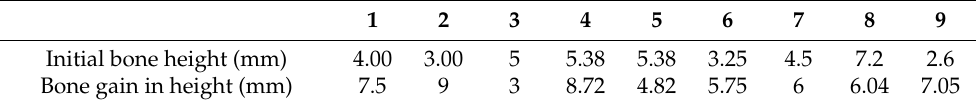
Table 2. Initial and 12 months postsurgical bone height, measured on CBCT sections in the same surgical implant